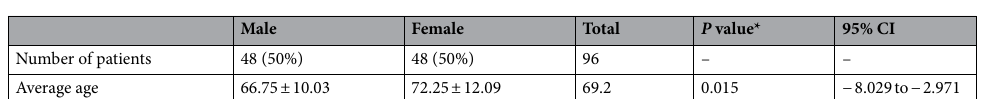
Figure 2. An example of accurate recognition of ERM in fundus photograph by AI model. ( A ) Grad-CAM image showing suspected location of ERM. ( B ) Original fundus photograph. ( C ) Merged image of fundus photograph and Grad-CAM. ( D ) Infrared fundus image of the same ERM eye, with red and green lines representing location of cross sectional OCT images. ( E , F ) Cross sectional OCT images across fovea showed ERM.